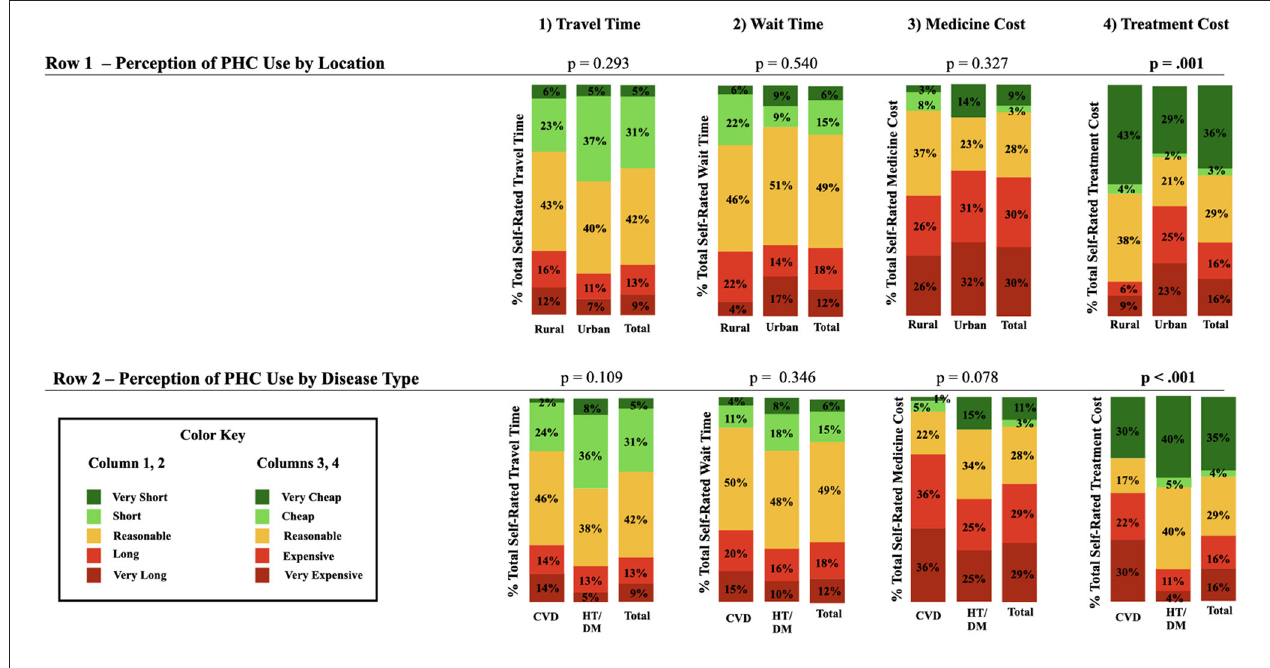
FIGURE 1 | Perception of PHC use.